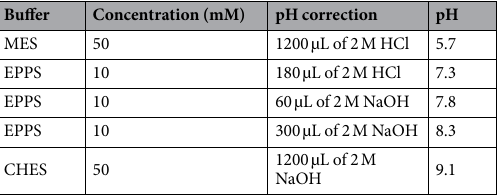
Table 1. Buffer and acid or base additions to control the pH of sludge dewatering liquors. MES, N-(morpholino)-ethane-sulfonic acid; EPPS, N-2-hydroxy ethylpiperazine-N9-propane-sulfonic acid; CHES, cyclohexylamino-ethane-sulfonic